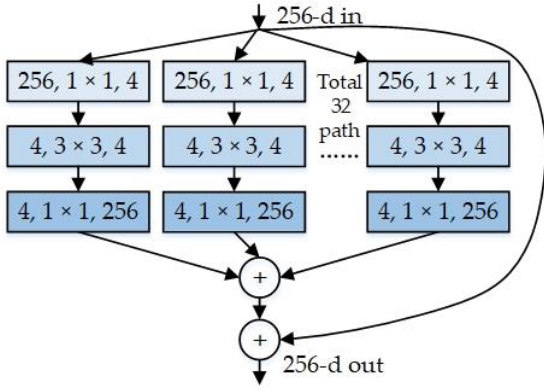
Figure 6. The block structures of Resnet and ResNext.